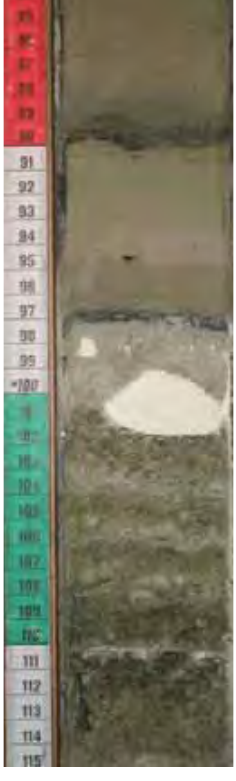
Figure 6. Sulfur nodule from ~99 to 101 cm in Core 6A-4H-2 near Pleistocene- Holocene boundary. Nodule formed near interface be- tween underlying gypsum sand (Unit II) below and overlying clay (Unit